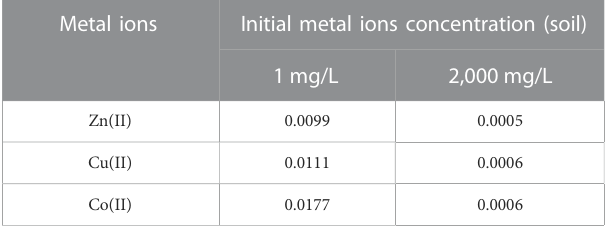
TABLE 4 Separation factor (SF) for sorption of metal ions from soil samples on the SBL. Metal ions